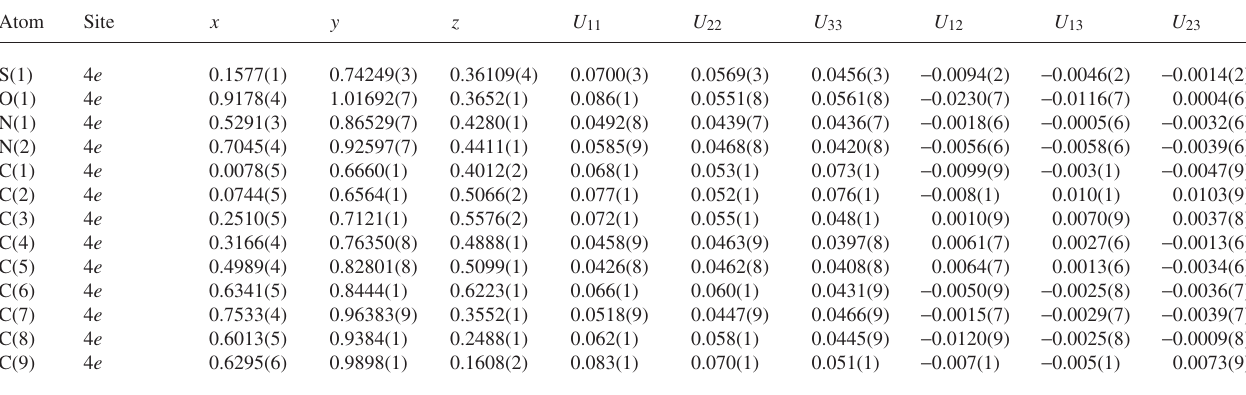
Table 3. Atomic coordinates and displacement parameters (in Å 2 )